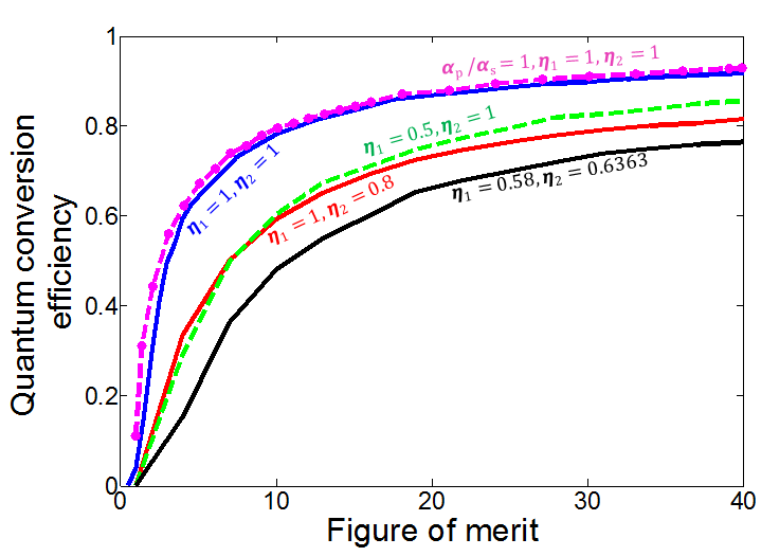
Figure 11. Simulated curves of quantum conversion efficiency